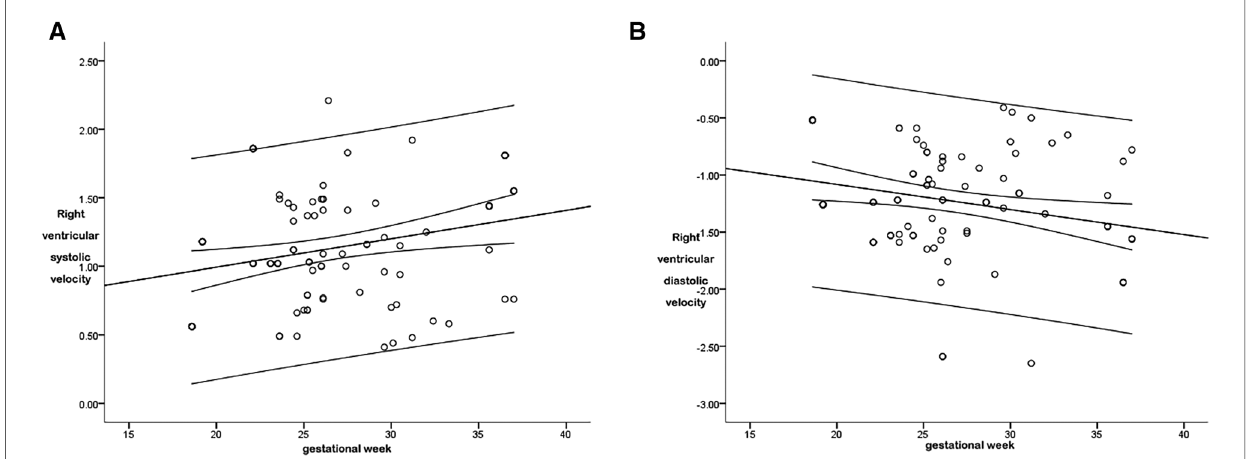
FIGURE 6 The scatter diagram of the relationship between the right ventricular global systolic ( A ) and diastolic ( B ) peak velocity and gestational age. As is shown in Figure 6A , there was a correlation between the right ventricular global systolic peak velocity and the gestational age ( P <0.05), with a correlation coef fi cient r =0.369, and the regression equation was calculated as follows: right ventricular global systolic velocity=0.579+(0.021×gestational age). As is shown in Figure 6B , there was a correlation between the right ventricular global diastolic peak velocity and the gestational age ( P <0.05), with a correlation coef fi cient r =0.353, and the regression equation was calculated as follows: right ventricular global diastolic velocity= − 0.644+( − 0.022× gestational